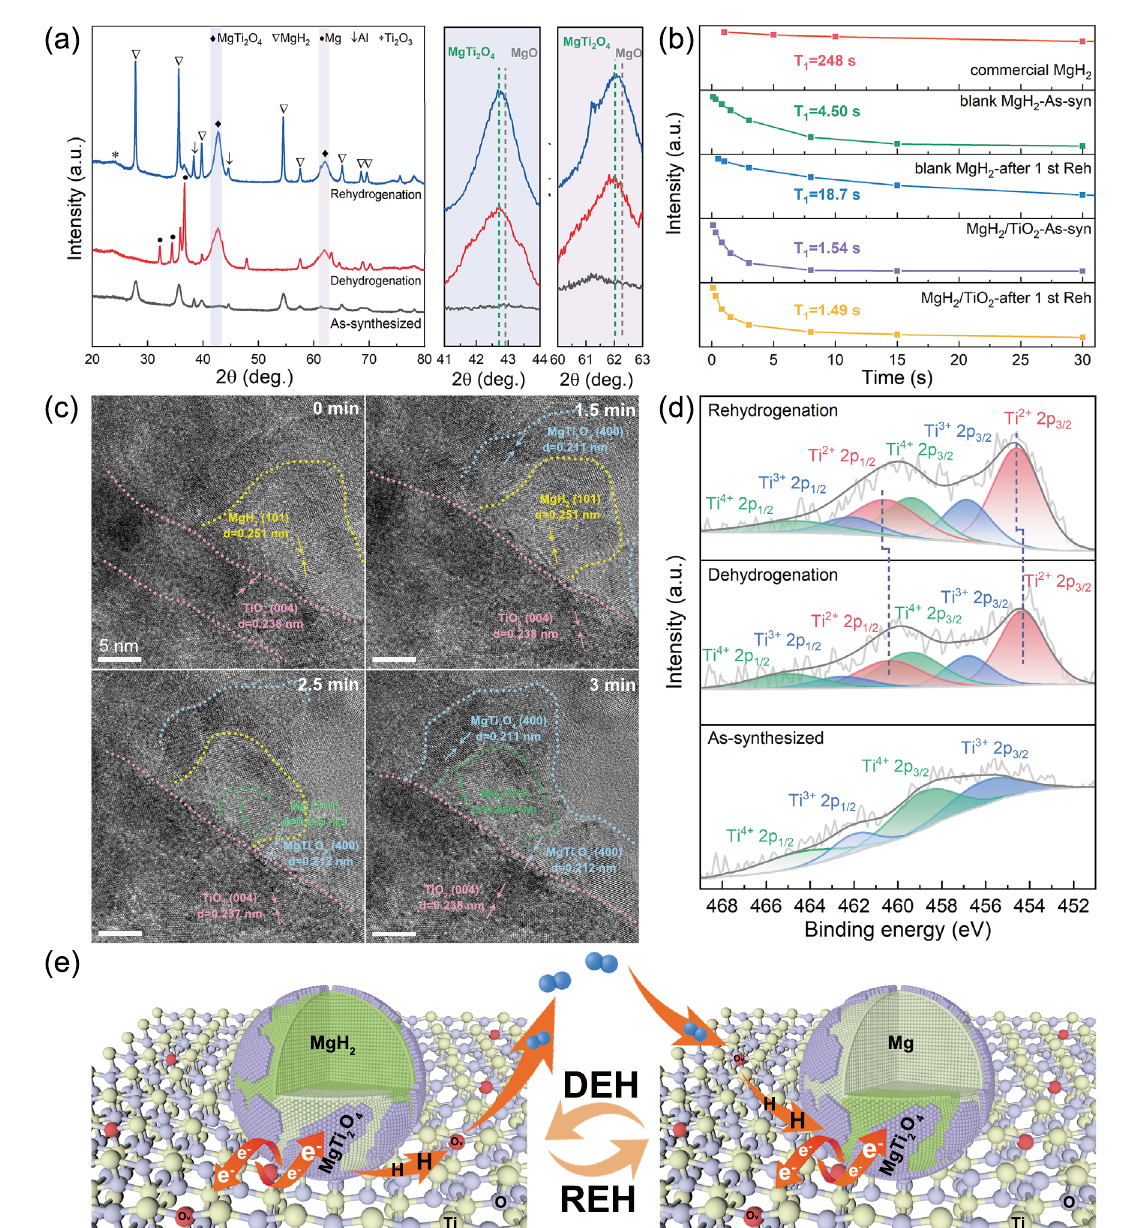
Fig. 6 a XRD patterns of the as-synthesized, dehydrogenated, and re-hydrogenated 60MgH 2 /TiO 2 heterostructure. b NMR spin lattice relaxa- tion times of 60MgH 2 /TiO 2 , commercial MgH 2 , and blank MgH 2 . c In situ HRTEM images showing the microstructure evolution of the hydro- genated 60MgH 2 /TiO 2 during the hydrogen desorption process. d High-resolution Ti 2 p spectra of 60MgH 2 /TiO 2 at different states. e Schematic diagram showing the hydrogenation and dehydrogenation mechanisms of MgH 2 /TiO 2